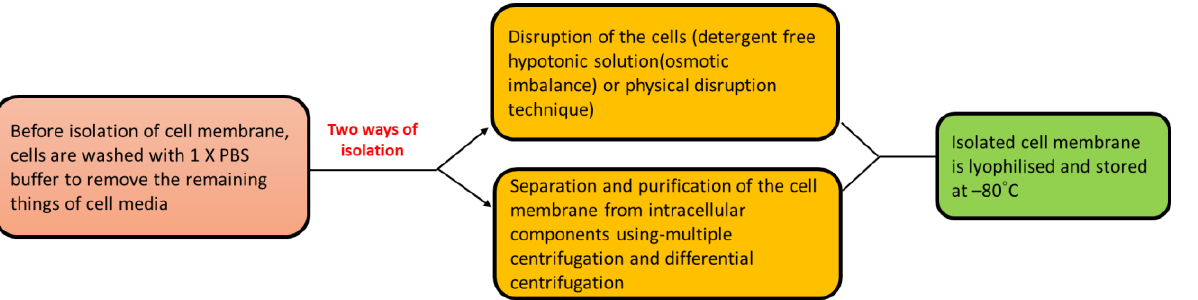
Figure 2. Overview of the isolation of cell membrane.